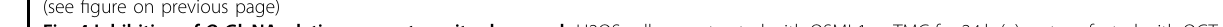
Fig. 4 Inhibition of O -GlcNAcylation promotes mitophagy. a , b U2OS cells were treated with OSMI-1 or TMG for 24 h ( a ), or transfected with OGT or OGA siRNAs for 48 hr ( b ). Cells were subjected to immuno fl uorescence microscopy with antibodies against TOM20, and the percentage of fragmented mitochondria was quanti fi ed. c – e U2OS cells were incubated with OSMI-1 or TMG for 12 h, and treated with or without RSL3 for 6 h. Cells were stained with MitoTracker and subjected to 3D - structured illumination microscopy with antibodies against TOM20 (mitochondrial outer membrane) and HSP60 (mitochondrial matrix) ( c ). Mitochondrial length ( d ) and incomplete mitochondria (mitochondria who lost their integrity and lack components such as inner membrane (yellow arrow), matrix (white arrow) or even both (pink arrow)) ( e ) were quanti fi ed. f U2OS cells were treated as indicated for 24 h and cell lysates were subjected to immunoblotting with indicated antibodies. g , h U2OS cells were treated with OSMI-1 or TMG for 24 h and subjected to immuno fl uorescence microscopy with antibodies against TOM20 and LC3 ( g ), and the number of LC3 puncta per cell was quanti fi ed ( h ). i U2OS cells were treated as described in h , and the number of p62 aggregates per cell was quanti fi ed. j U2OS cells were treated as described in h . Cells were stained with antibodies against HSP60 and LAMP1. k U2OS cells were transfected with mt-Keima and treated with OSMI-1 or TMG for 24 h, and then assessed with confocal microscopy. l , m U2OS cells were treated with DMSO or OSMI-1 for 24 h and subjected to TEM ( l ). Mitochondrial diameter was quanti fi ed ( m ). n U2OS cells were transfected with control or PINK1 siRNAs for 48 h and treated with DMSO or OSMI-1 for 12 h, and then induced with RSL3 for 3 h. Cells were stained with PI and assessed by fl ow cytometry. * P < 0.05, ** P < 0.01, **** P < 0.0001; ns, not signi fi cant. Scale bars, 10 μ m unless speci fi cally indicated. Error bars indicate